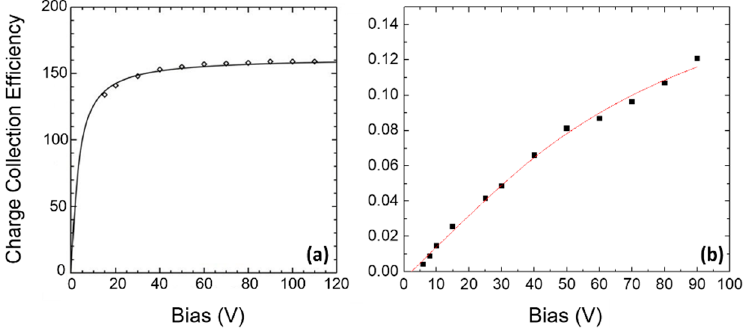
Figure 13. Charge collection efficiency measured as a function of bias voltage for ( a ) electrons in a THM grown Cd 0.9 Zn 0.1 Te 0.97 Se 0.02 (Adapted from ref. [17]. Copyright 2019 Nature Research under Creative Commons Attribution 4.0 International License) and ( b ) holes in a VBM grown Cd 0.9 Zn 0.1 Te 0.97 Se 0.03 planar detector (Adapted with permission from ref. [21]. Copyright 2020, AIP Publishing). The solid lines are the Hecht equation fit. Note that the charge collection efficiency in (a) is expressed as the MCA channel number.